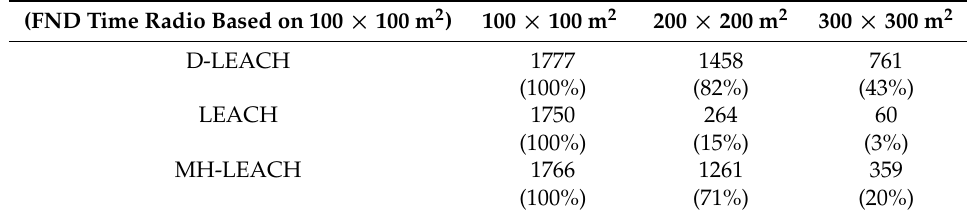
Figure 16. Time of occurrence of death of the first node (FND). Table 2. FND time ratio according to network